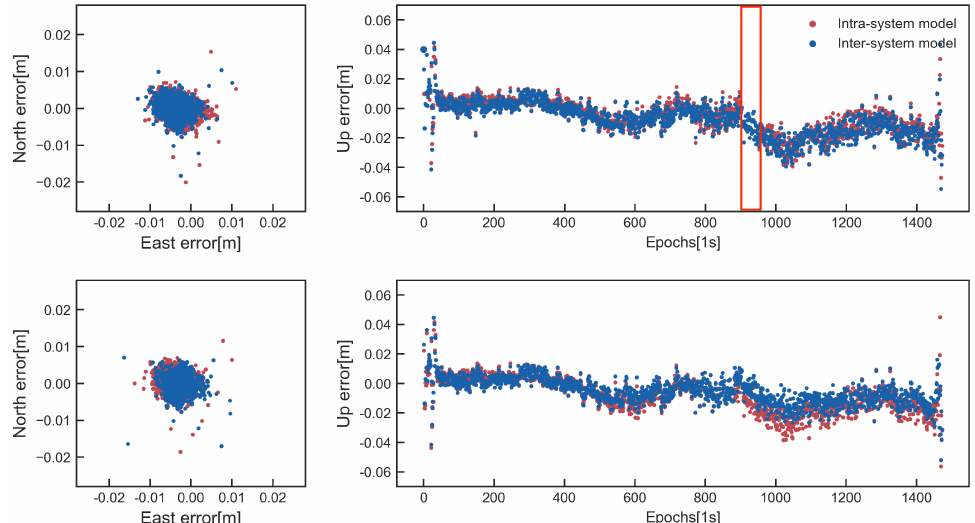
Figure 12. Horizontal position scatter and corresponding vertical time series for the intra − system model (red dots) and the inter − system model (blue dots) for the case of GPS + 3 Galileo ( top ) and GPS + 4 Galileo ( bottom